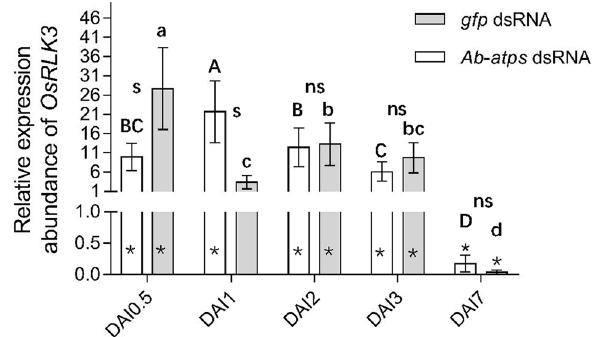
Figure. 8. Expression of the OsRLK3 gene in rice tissue at different times after inoculation with Aphelenchoides besseyi treated with dsRNA. Bars indicate standard errors of mean data (n = 3) from three biological and two technical replicates each containing a pool of 3 plants. Data are shown as relative expression levels of treated/ untreated tissue in comparison with the control tissue. Gene expression levels were normalized using the internal reference gene OsUBQ5 . Uppercase letters indicate significant differences ( p < 0.05) among treatments when rice plants were inoculated with A. besseyi treated with Ab-atps dsRNA. Lowercase letters indicate significant differences ( p < 0.05) among treatments when rice plants were inoculated with A. besseyi treated with gfp dsRNA. The asterisk (*) indicates significant differential expression compared with healthy rice plants (p < 0.05). s: significant difference ( p < 0.05) between rice plants inoculated with A. besseyi treated with Ab-atps dsRNA and gfp dsRNA at the same time points. ns: not significant ( p > 0.05) between rice plants inoculated